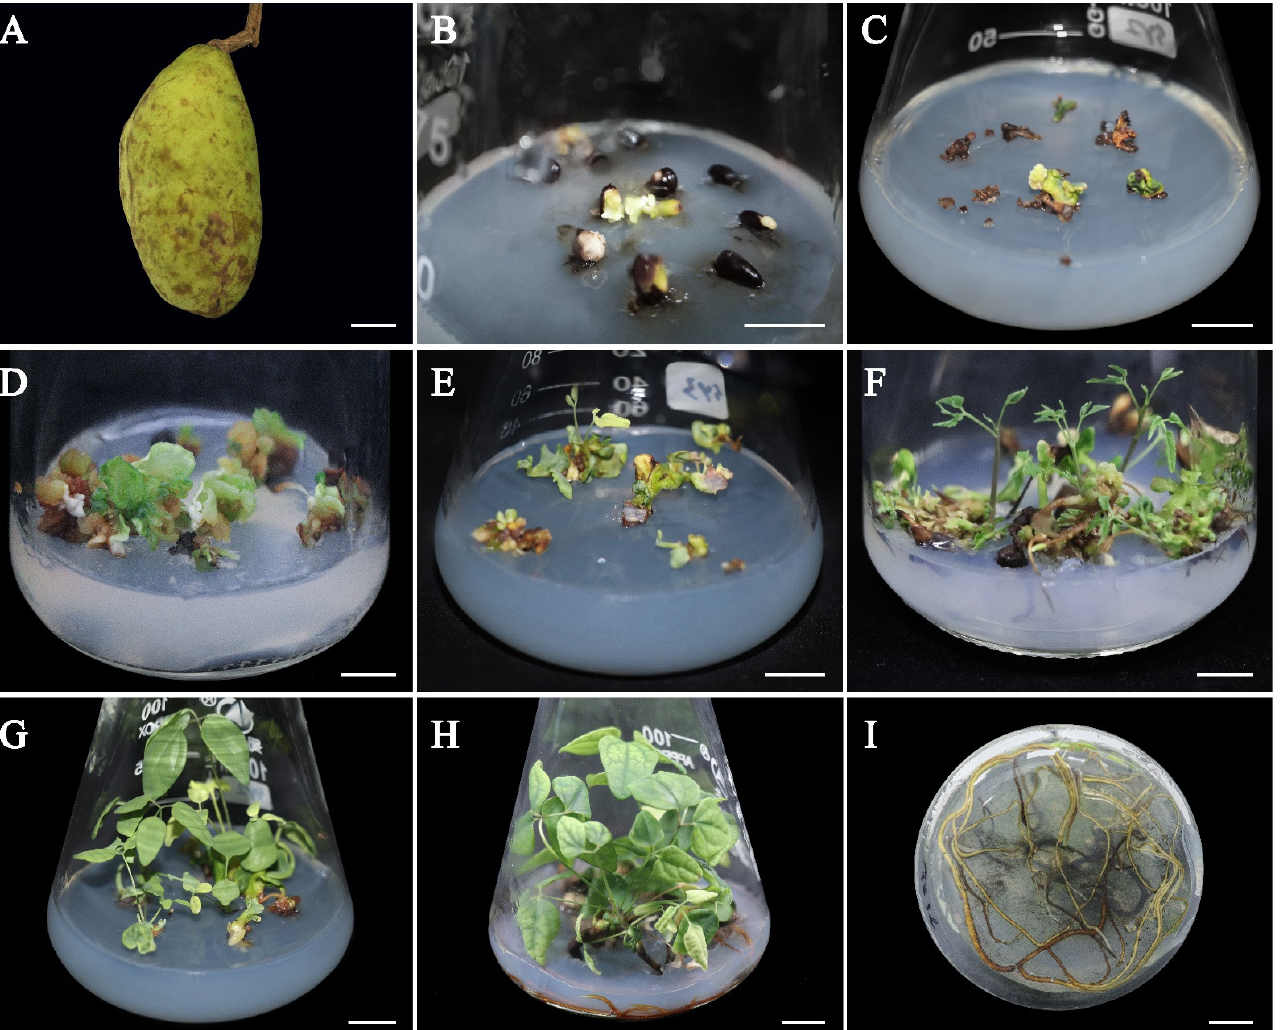
Figure 1. SEs induction and plant regeneration from the immature seeds of wild A. trifoliate . ( A ) Immature fruits harvested from a wild A. trifoliate tree 10 weeks after open pollination. ( B ) Induced SEs after 2 months of culture on the WPM medium containing 1.0 mg L − 1 of TDZ and 1.0 mg L − 1 of 2,4-D (the SEI5 medium). ( C ) Browning and even dead SEs observed on the WPM medium containing 2.0 mg L − 1 of 6-BA (the SEM3 medium) after culture for one month. ( D ) Secondary SEs occurred on the WPM medium containing 1.0 mg L − 1 of 6-BA (the SEM2 medium) after 2 months of culture. ( E ) Adventitious shoots initiated after 3 months of culture on the SEM2 medium. ( F ) Numerous adventitious shoots regenerated on the SEM2 medium after culture for 4 months. ( G ) Roots initiated from the SEs after about 20 days of culture on the WPM medium containing 1.0 mg L − 1 of IBA and 1.0 mg L − 1 of TDZ (the RI2 medium). ( H , I ) Plants regenerated ( H ) and well-developed roots formed ( I ) after 2 months of culture on the RI2 medium. Bars = 1 cm.